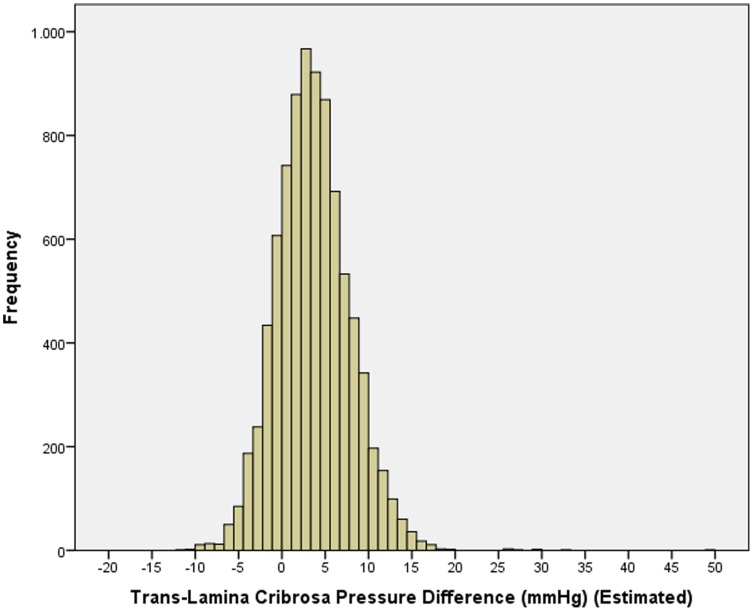
Histogram showing the distribution of the estimated trans-lamina cribrosa pressure difference in the non-glaucomatous eyes of the Central India Eye and Medical Study.